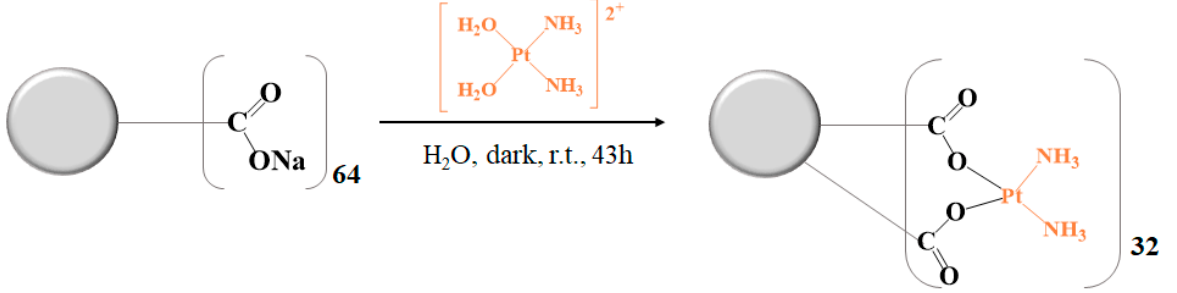
Scheme 8. Representation of the synthesis of the PAMAM dendrimer G3.5 functionalized with cisplatin in bidentate form, G3.5COO(Pt(NH 3 ) 2 )